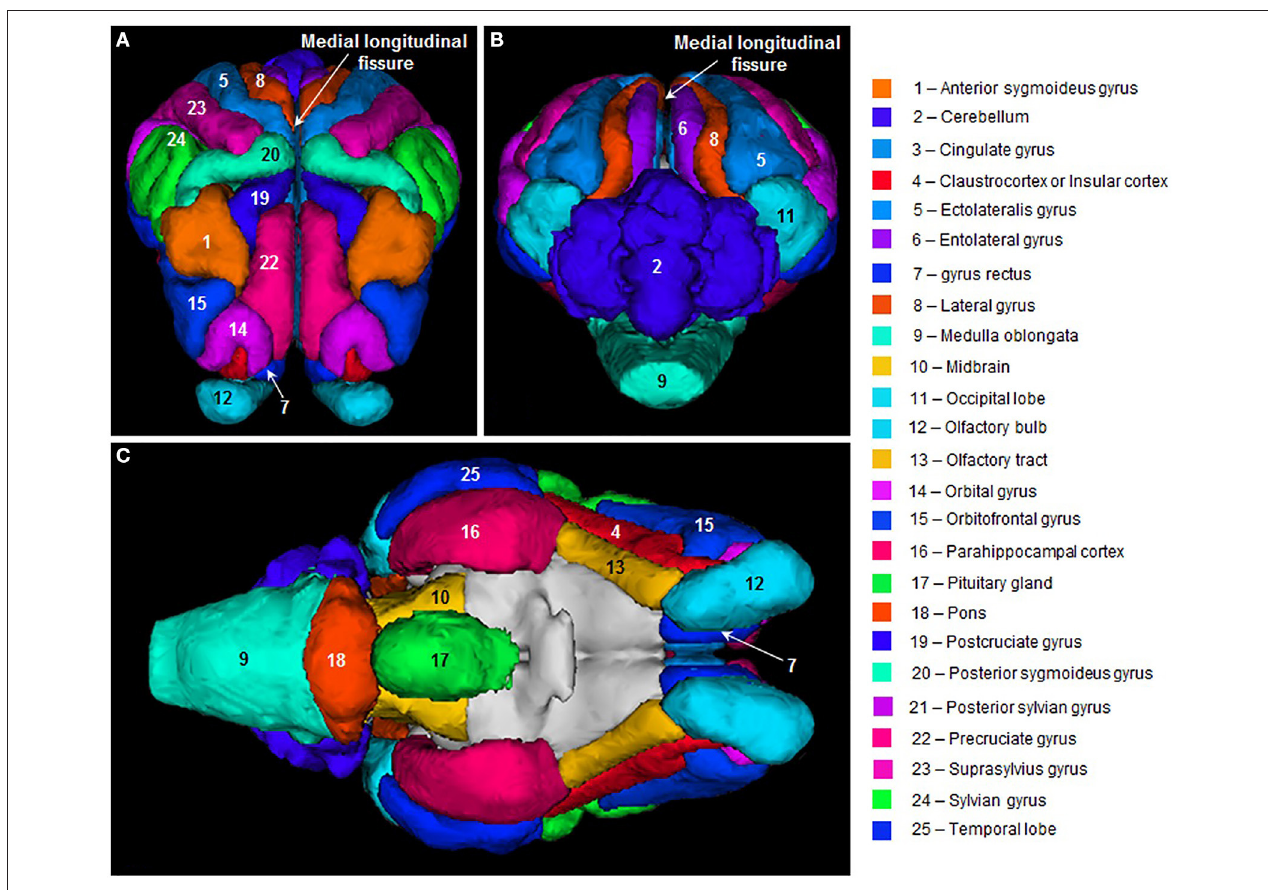
FIGURE 2 | Sheep brain MRI atlas. 3D surface renderings of gyri segmented from a population-average template MR images of sheep brains displayed in: (A) frontal, (B) posterior, and (C) ventral views. Figure reproduced from Computation of a high-resolution MRI 3D stereotaxic atlas of the sheep brain by Ella et al. (1) with permission from John Wiley and